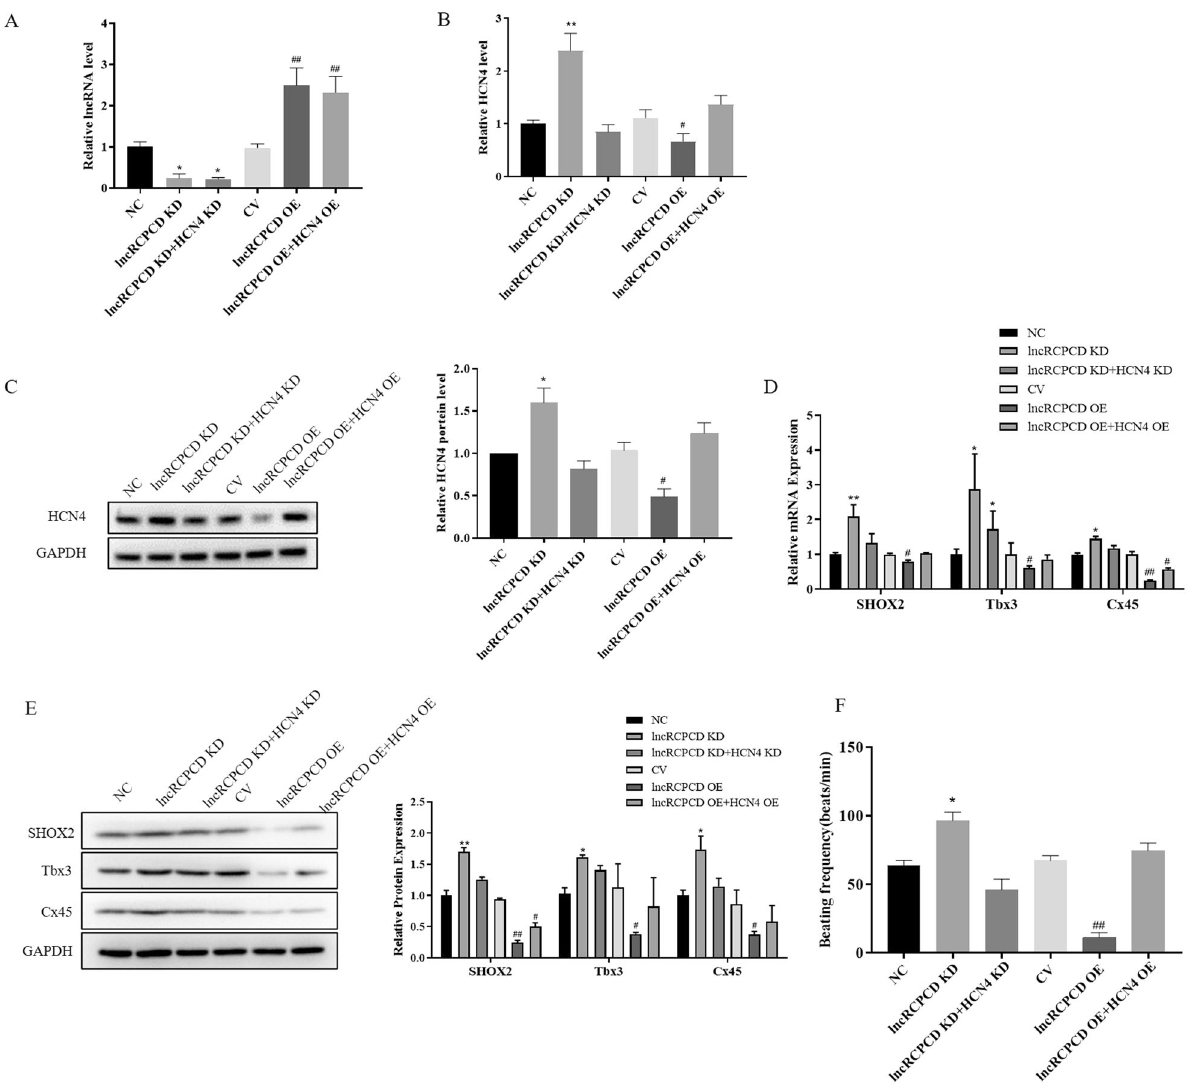
Fig. 6 LncRNA RCPCD inhibited differentiation of ESCs into pacemaker-like cells by inhibiting the expression of HCN4. ESCs were cultured in a differentiation medium to form pacemaker-like cells. At cultured 3 days, ESCs divided into six groups and transfected adenovirus: negative control shRNA adenovirus, RCPCD shRNA adenovirus, RCPCD shRNA adenovirus, and HCN4 shRNA adenovirus, control vector adenovirus, RCPCD vector adenovirus, RCPCD vector adenovirus, and HCN4 vector adenovirus. At cultured 6 days, the same transfection was performed again. These group differentiated ESCs were collected and detected at d6 + 10. A qRT-PCR detected the expression of RCPCD. B qRT-PCR detected the expression of HCN4 at mRNA levels. C The expression of HCN4 at protein levels was detected by western blot. D qRT-PCR detected the expression of Tbx3, Cx45, and SHOX2 at mRNA levels. E The expression of Tbx3, Cx45, and SHOX2 at protein levels were detected by western blot. F Beating frequency was counted in these differentiated ESCs at d6 + 10. * P < 0.05, ** P < 0.01, * as the difference that compared with negative control transfected group. # P < 0.05, ## P < 0.01, # as the difference that compared with control vector-transfected group. Error bars were represented the mean ± SD in triplicate